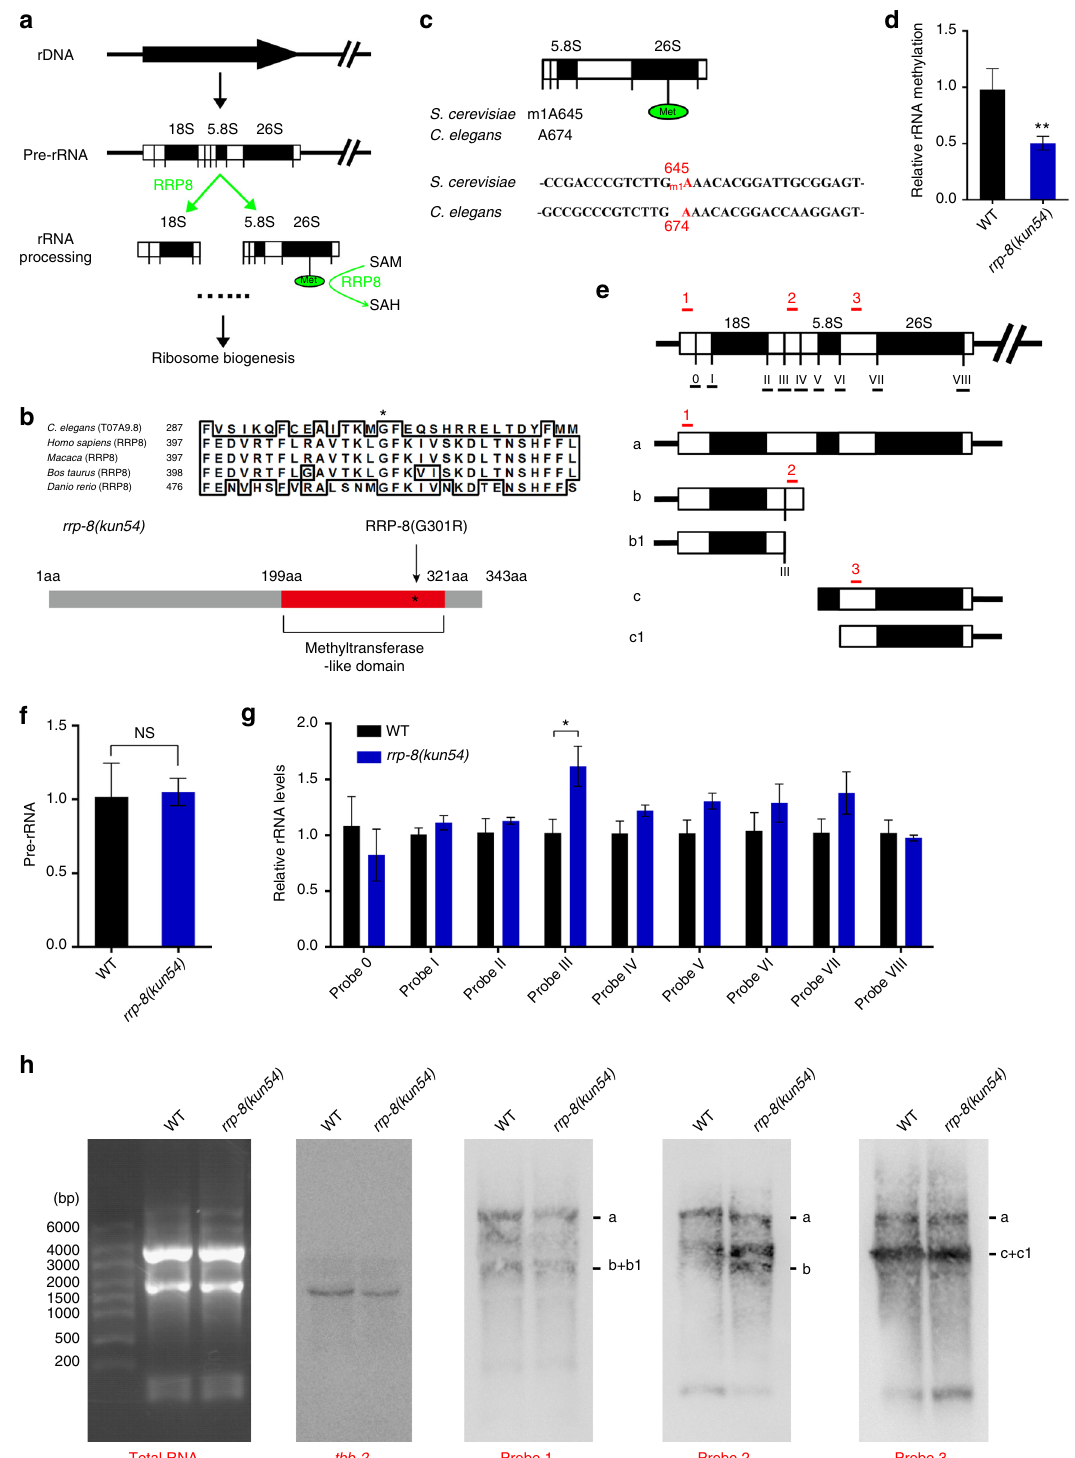
(Supplementary Fig. 4B). Both the sbp-1 ( ep79 ) and daf-16 ( mu86 ) mutants were incapable of suppressing the excessive lipid accumulation in the rrp-8 ( kun54 ) mutant (Supplementary Fig. 4C and D). Altogether, these results suggest that nucleolar stress-induced lipid accumulation may not be dependent on these factors. and worms